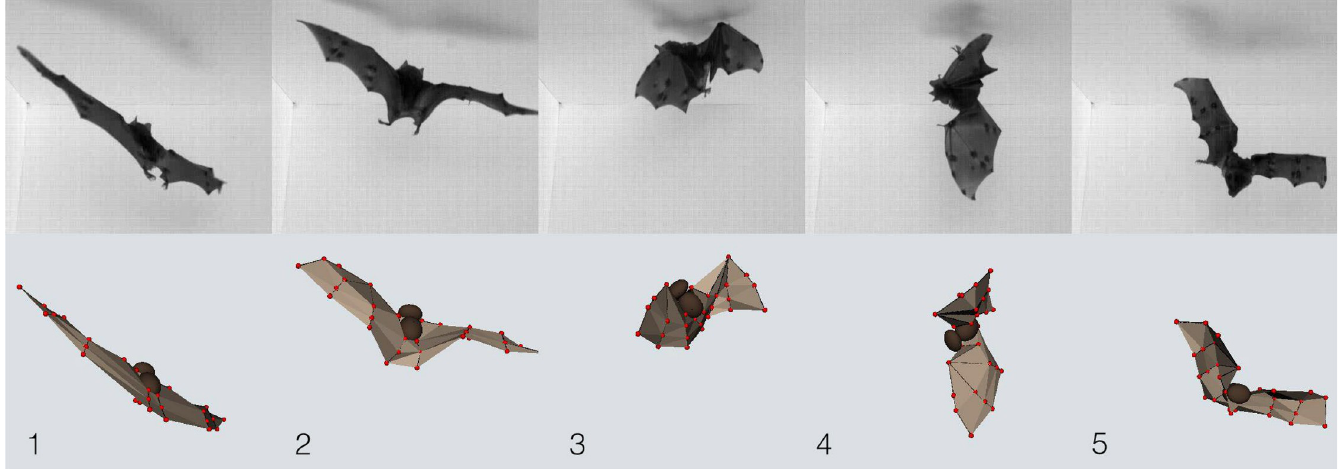
Fig 4. Top row: Movie stills taken as a Seba’s short-tailed bat ( Carollia perspicillata ) tries–and fails–to land on the ceiling. Bottom row: 3D reconstruction of this activity. Image reproduced under CC-BY 4.0 license, credit: 10.1371/journal.pbio.1002297.